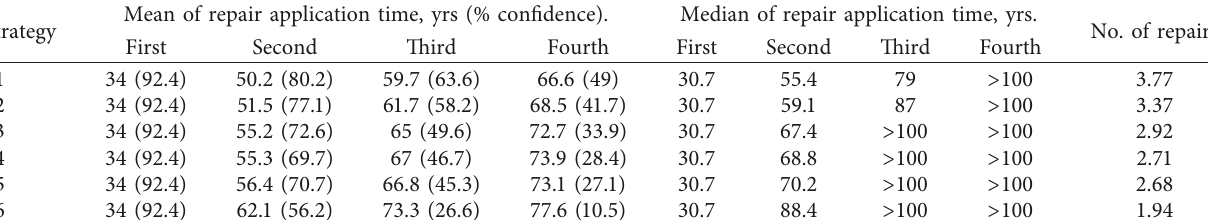
Table 6: Comparison of six repair strategies from probabilistic assessment. Mean of repair application time, yrs (% confidence). Strategy